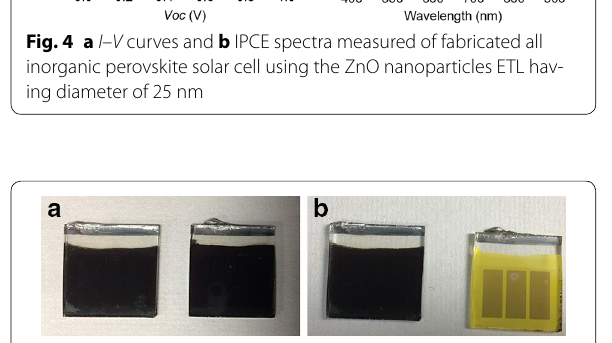
3 mm 2 defined by a black mask ×